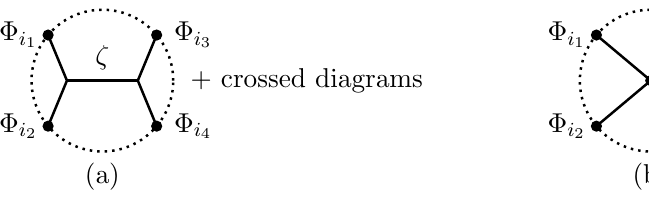
( t 1 ) (cid:1) (cid:1) (cid:1) (cid:8) i ( t 4 ) ⟫ . 1 4